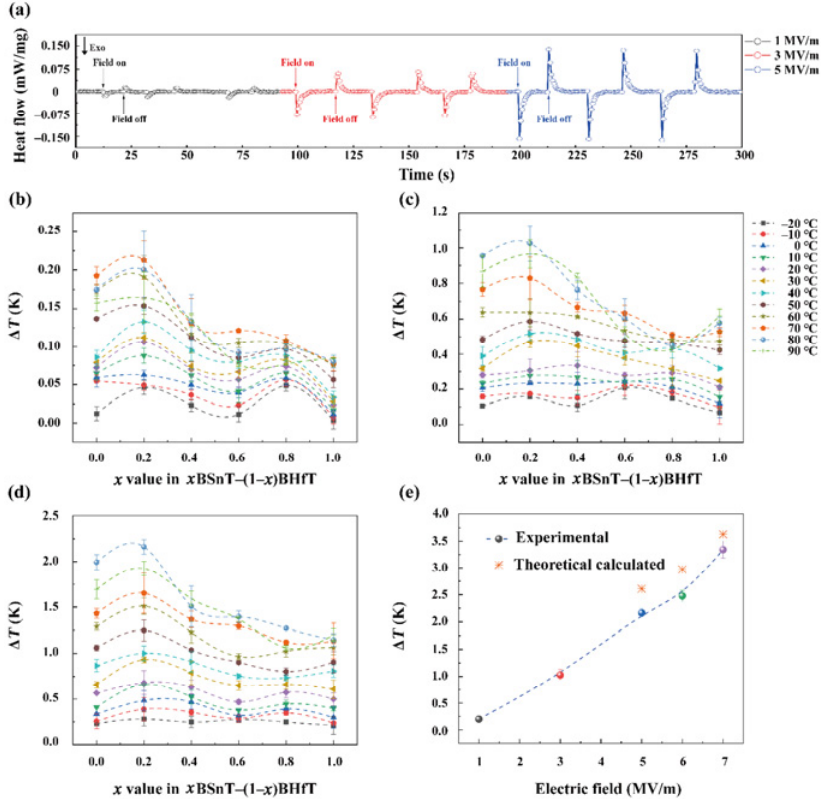
Fig. 4 (a) Heat flow as a function of time and external electric field for x = 0.2 ceramics: 1 MV/m (black line), 3 MV/m (red line), and 5 MV/m (blue line) at 80 ℃ . Directly measured ECE results for x BSnT–(1 − x )BHfT ceramics under (b) 1 MV/m, (c) 3 MV/m, and (d) 5 MV/m. (e) Directly measured and theoretically calculated ECE results as a function of electric field for x = 0.2